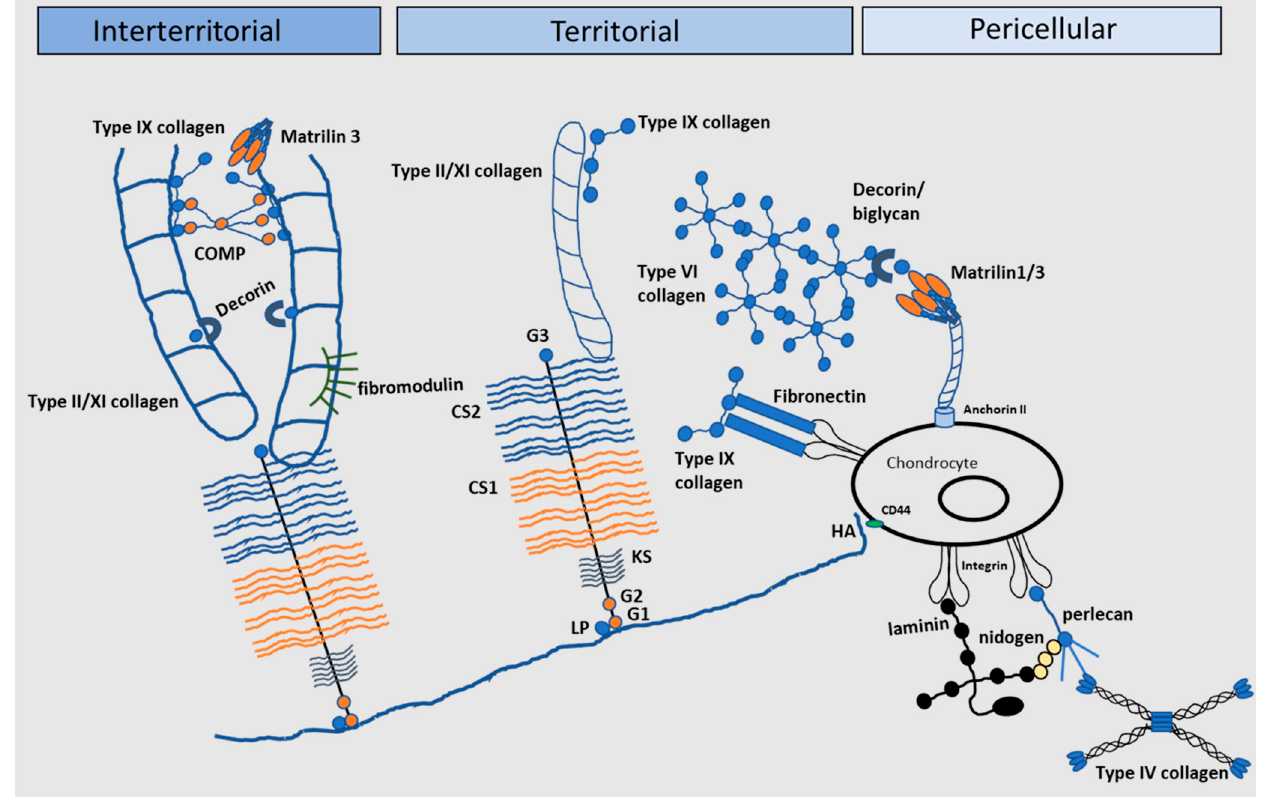
Figure 3. The extracellular matrix of articular cartilage. The extracellular matrix (ECM) of articular cartilage is comprised largely of collagen and proteoglycans, with smaller amounts of other non-collagenous proteins and glycoproteins. Large proteoglycan aggregates such as aggrecan interact with collagens and contain chondroitin sulphate (CS) and keratan sulphate (KS), covalently linked to hyaluronic acid (HA) by link protein (LP). Matrilin-1, -3 and -4, decorin, COMP and type IX collagen link the type II/XI collagen fibrils and mediate interactions between the collagen network and the aggrecan matrix (G globular) (Adapted from [81]).